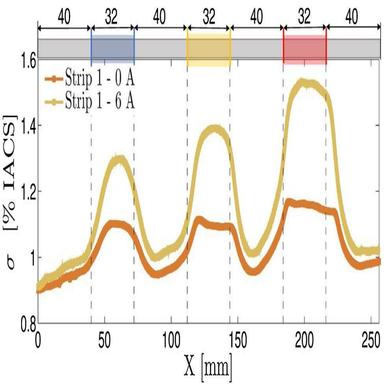
Electrical conductivity profile of FGM using eddy current testing for room temperature (I = 0 A) and 90 °C (I = 6 A).